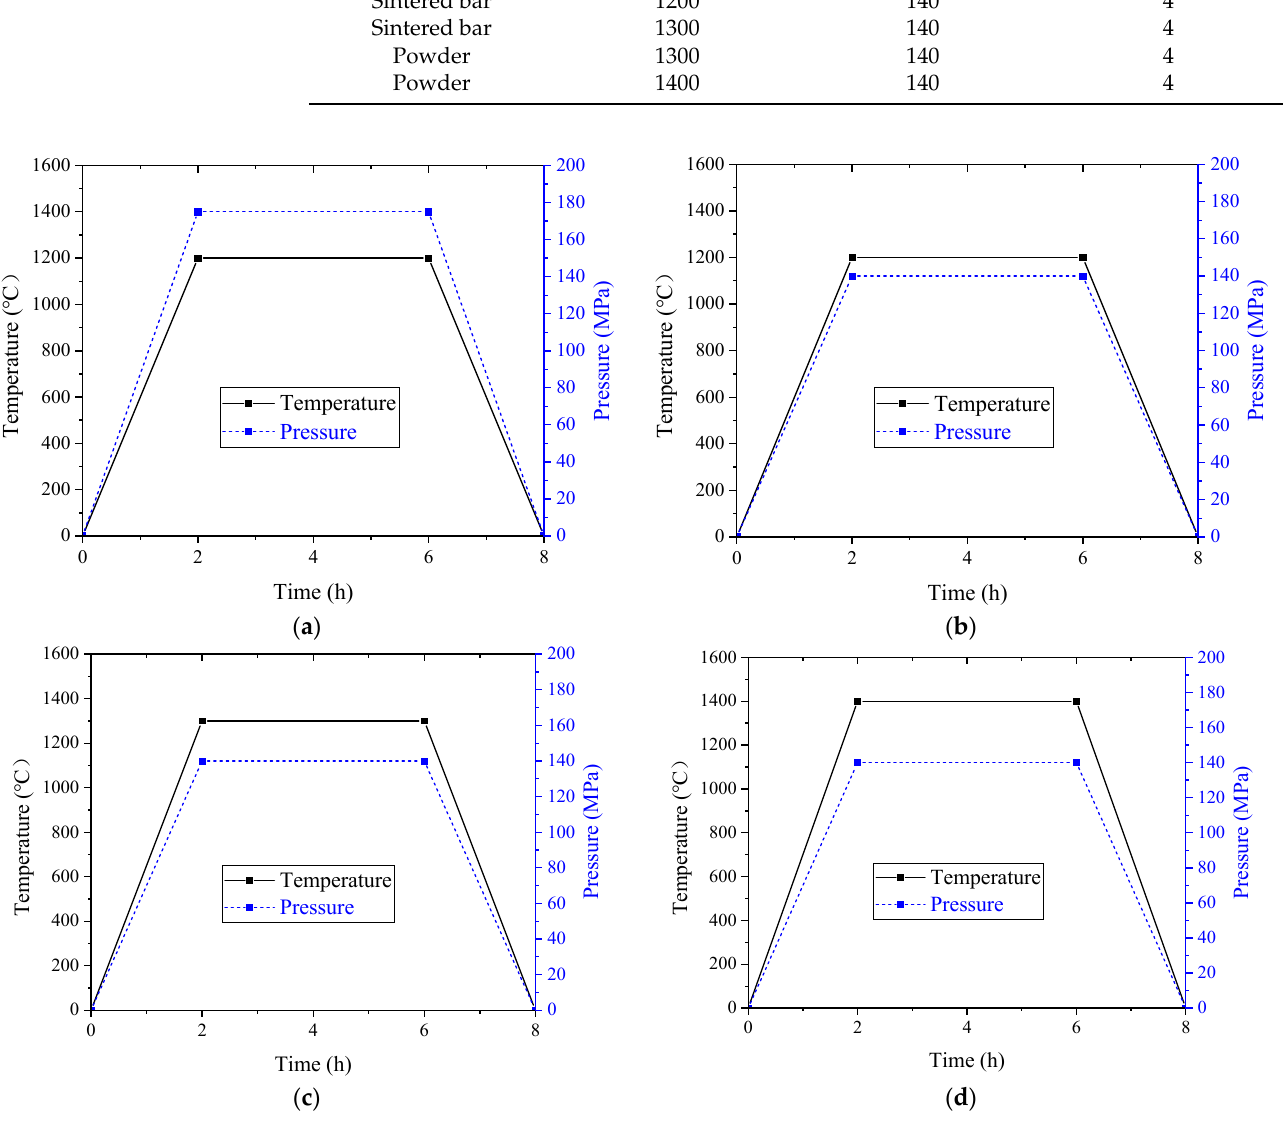
Figure 4. HIP strengthening loading curve of tungsten alloy : ( a ) 1200 °C, 175 MPa; ( b ) 1200 °C, 140 MPa; ( c ) 1300 °C, 140 MPa; ( d ) 1400 °C, 140 MPa.